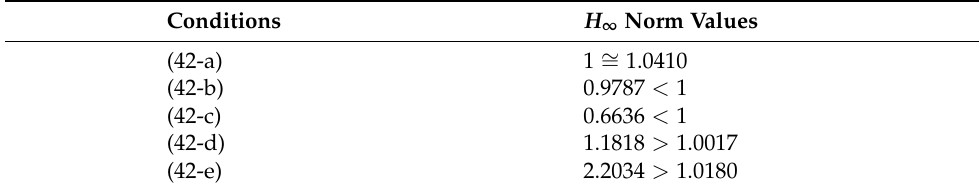
Table 1. H ∞ norm value of weighting and sensitivity